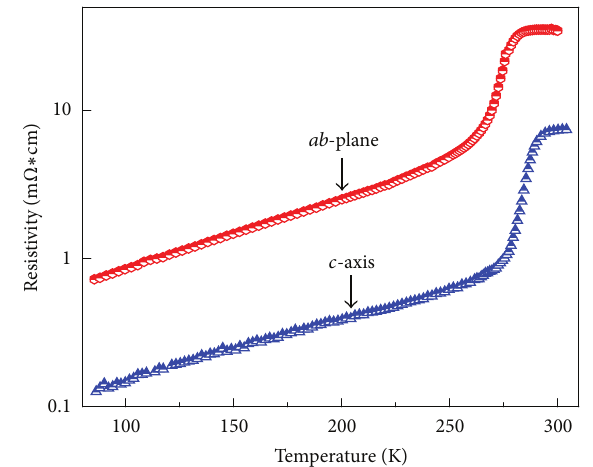
Figure 1: Resistivity versus temperature plot for the single crystal of La 0.7 Ca 0.24 Sr 0.06 MnO 3 .